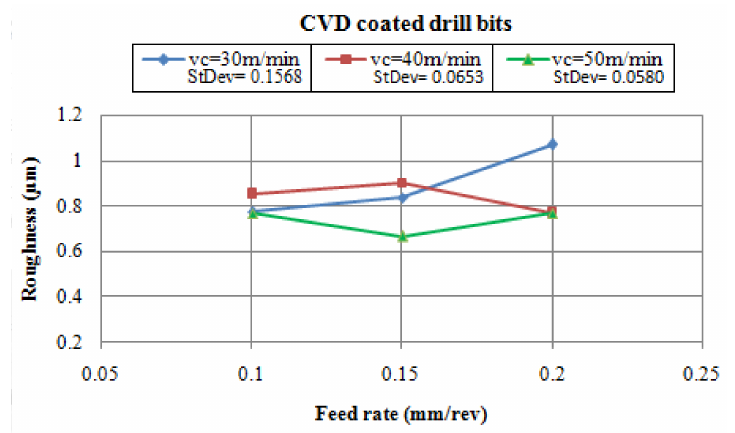
Figure 11. Surface roughness with feed rates at different cutting speeds when using CVD-coated drill bits.